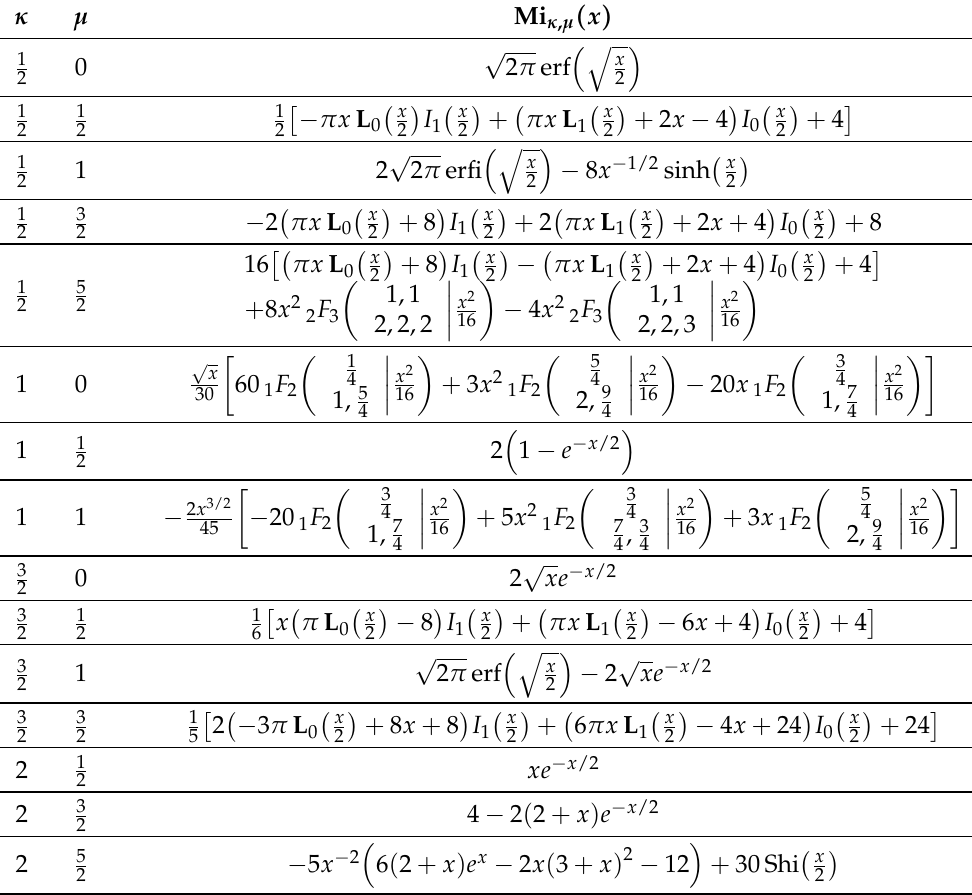
Table 6. The integral Whittaker functions Mi κ , µ derived for some values of parameters κ and µ by using (18) and (19).